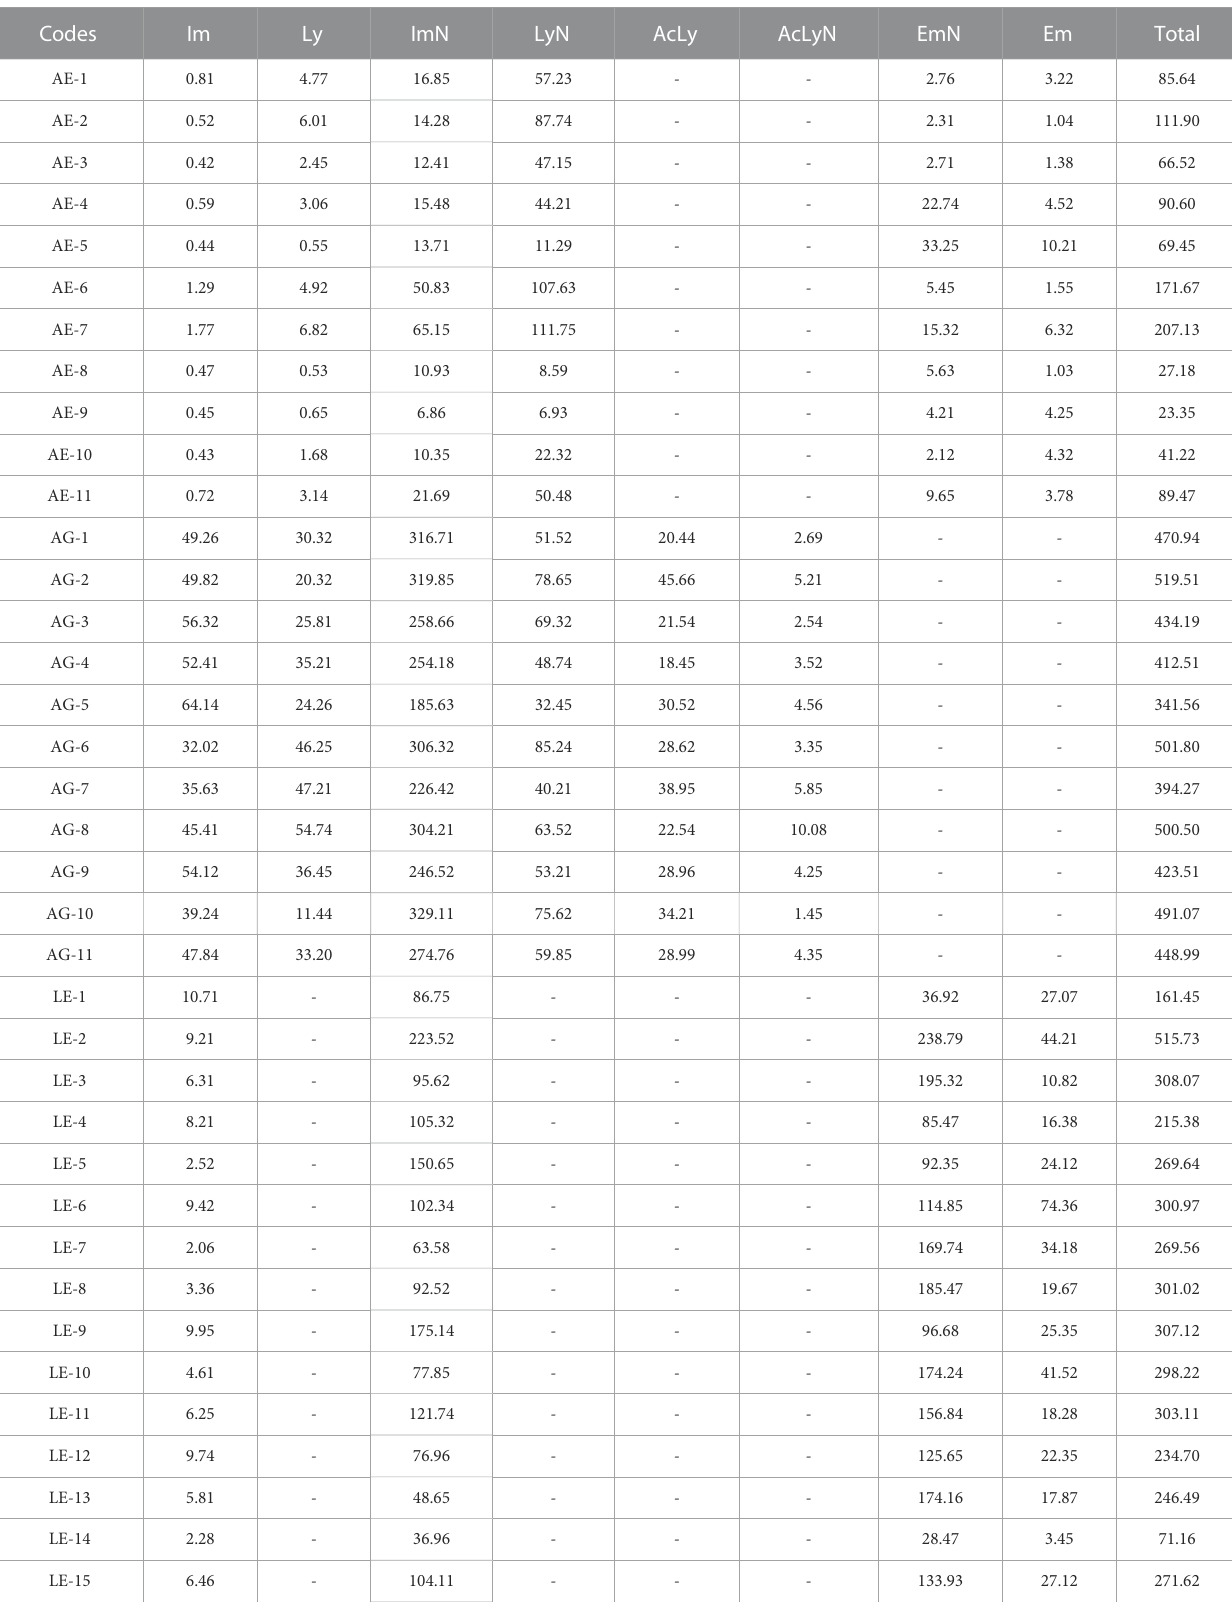
TABLE 6 The results of sample determination ( μ g · g − 1 ).